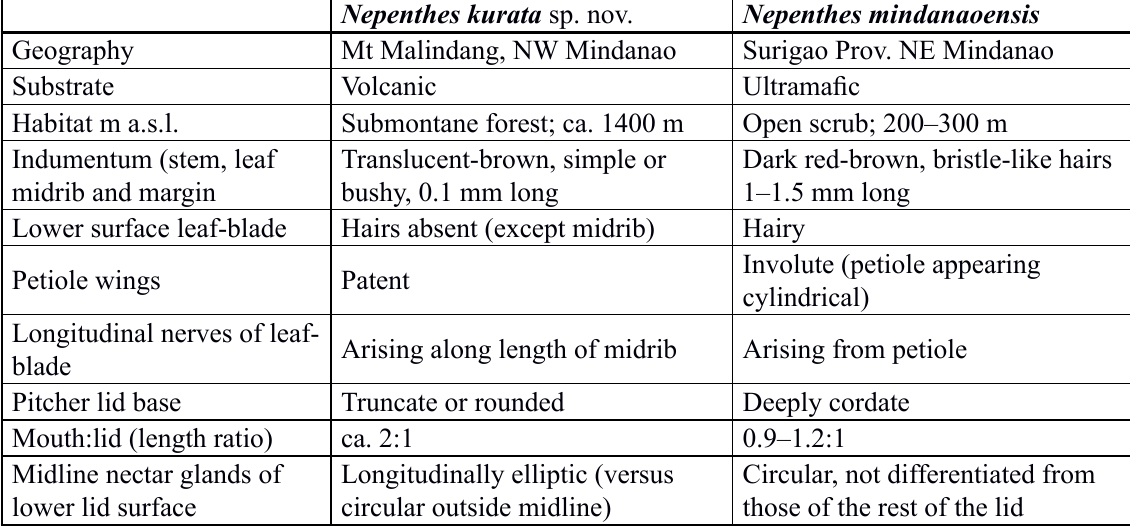
Table 1. Diagnostic characters separating N. kurata sp. nov. and N. mindanaoensis